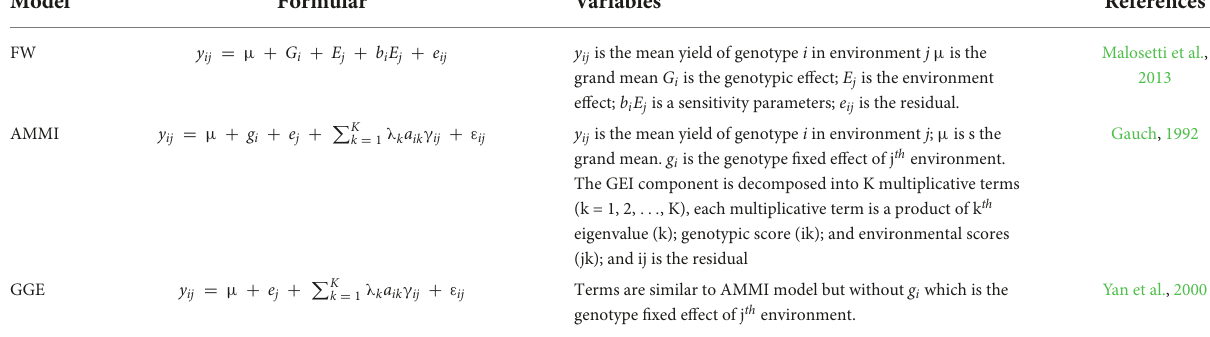
TABLE 2 Description of models and